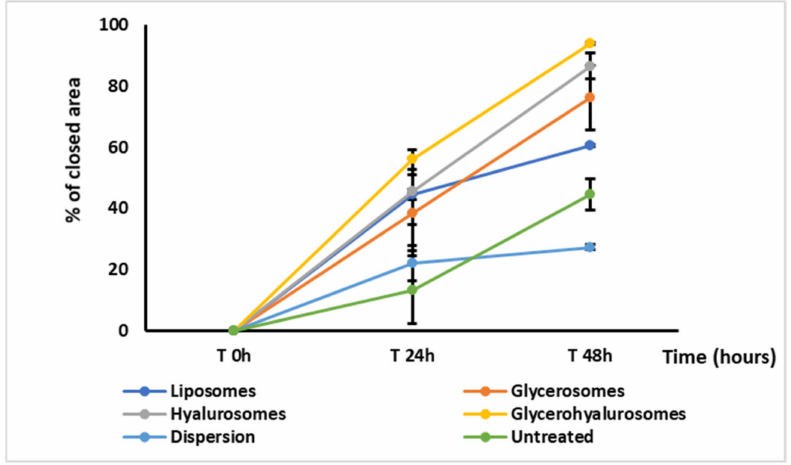
Figure 7. Percentage of wound closure in a monolayer of fibroblasts untreated or treated with canthaxanthin in dispersion or loaded in vesicles at 0 h, 24 h, and 48 h. Mean values ± standard deviations (error bars) are reported ( n =